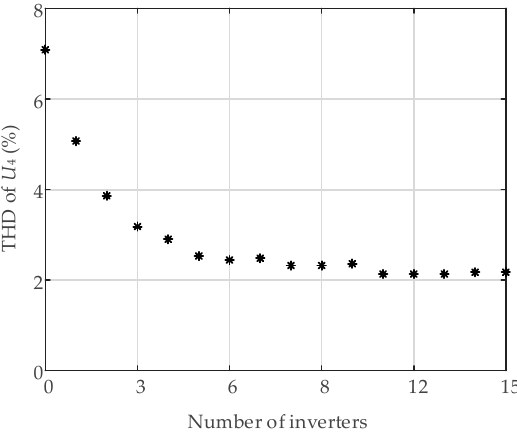
Figure 14. Effect of the number of inverters on THD of U 4 .